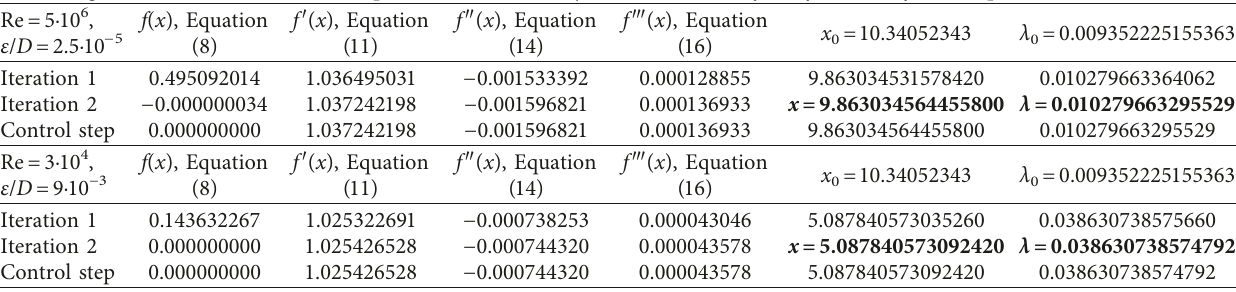
0 depends on input parameters: Equation (2), indirect calculation